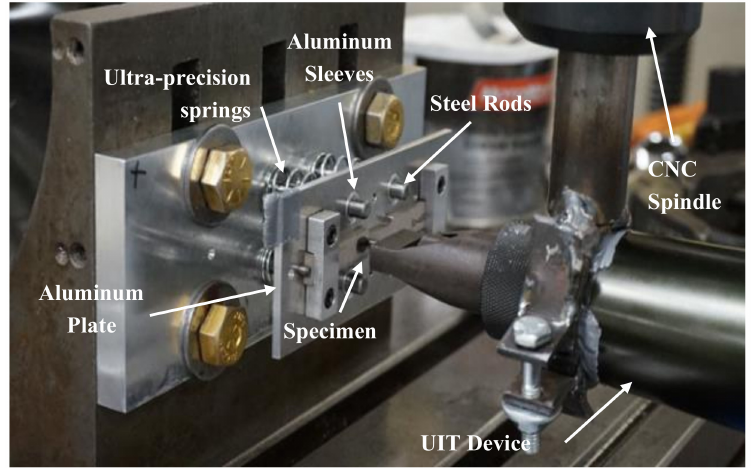
Figure 3. Spring assembly fixture with a clamp mounted to the CNC